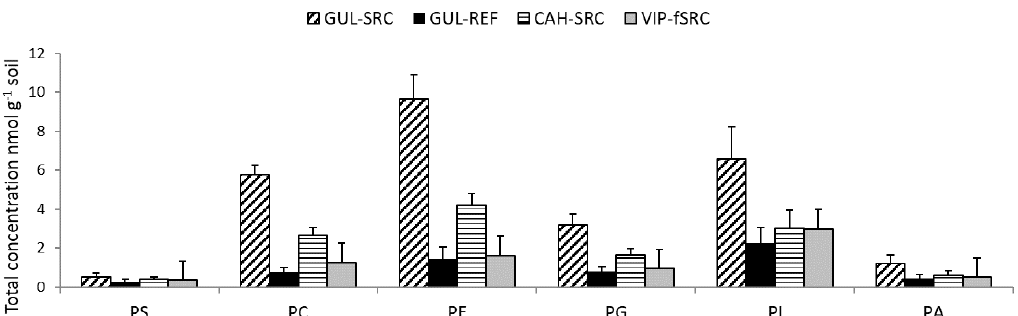
Figure 4. Phospholipid composition of the upper topsoil (0–5 cm soil depth) under short rotation coppice (SRC) and a reference site with cereals (REF) at the test site Gülzow (GUL) and Cahnsdorf (CAH) and a former SRC (fSRC) with hybrid poplar clones 4 years after return to tilled annual crops at the test site Vipperow (VIP) as determined by Q-TOF MS / MS analysis (n = 5): Total concentration of major phospholipid classes (phosphatidylserine, PS; phosphatidylcholine, PC; phosphatidylethanolamine, PE; phosphatidylglycerol, PG; phosphatidylinositol, PI; phosphatidic acid, PA) in nmol g − 1 soil dry weight.